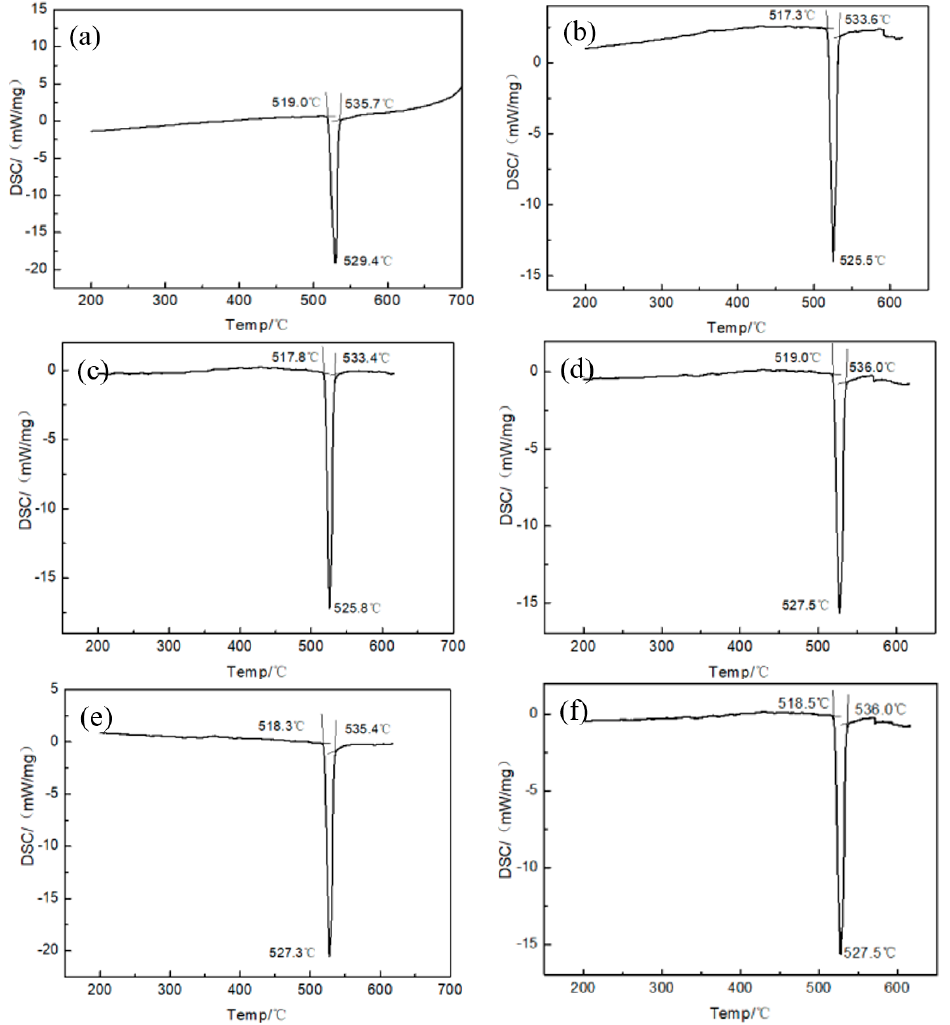
Figure 5. Differential scanning calorimetry (DSC) curve of the melt-spun ribbons with chemical compositions of ( a ) Al-7.5Si-23.0Cu-2.0Ni-0.0Ti; ( b ) Al-7.5Si-23.0Cu-2.0Ni-0.5Ti; ( c ) Al-7.5Si-23.0Cu-2.0Ni-1.0Ti; ( d ) Al-7.5Si-23.0Cu-2.0Ni-1.5Ti; ( e ) Al-7.5Si-23.0Cu-2.0Ni-2.0Ti; ( f ) Al-7.5Si-23.0Cu-2.0Ni-2.5Ti. Table 2. Solidus and liquidus temperature of melt-spun ribbons with different chemical composition. Chemical Composition of Melt-Spun Liquidus Temperature Solidus Temperature (°C) Ribbon (wt.%) (°C) Al-7.5Si-23.0Cu-2.0Ni-0.0Ti